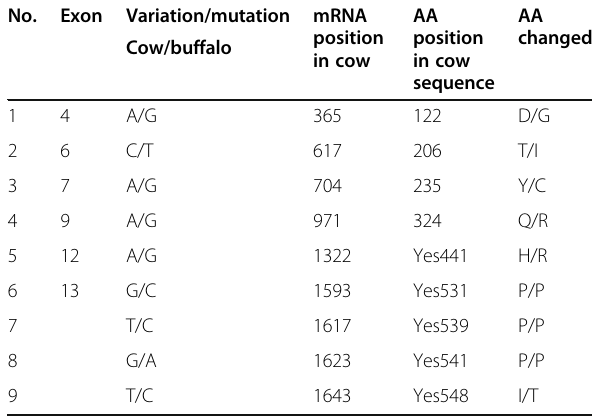
Table 4 List of nucleotides differences between cow and buffalo in 6